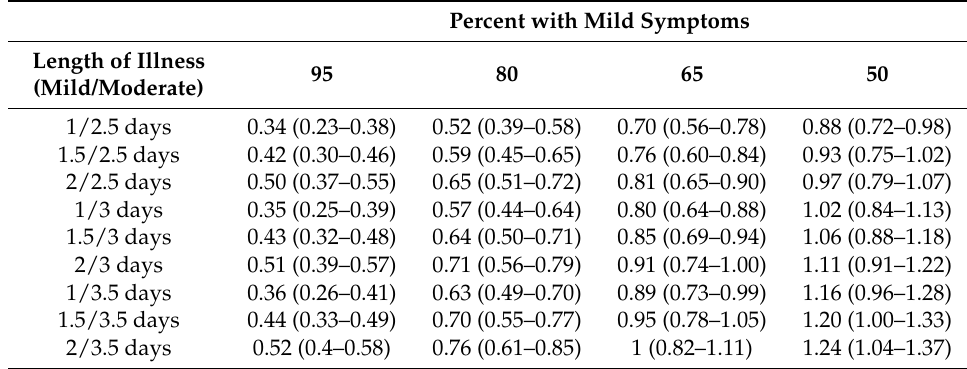
Table 2. Estimated DALYs per 1000 cases of